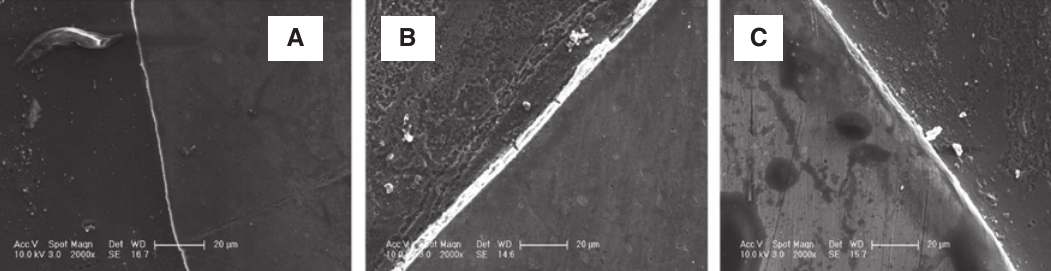
Figure 11: SEM images taken at same magnification showing IM thickness “t” at central WN region of samples S4, S5 and S6. (A) For sample S4 with IO = 0.76 mm in RS, average t = 1.2 μ m. (B) For sample S5 with IO = 0.30 mm in RS, average t = 3 μ m. (C) For sample S6 with IO = 0.04 mm in AS, average t = 2.5 μ m.